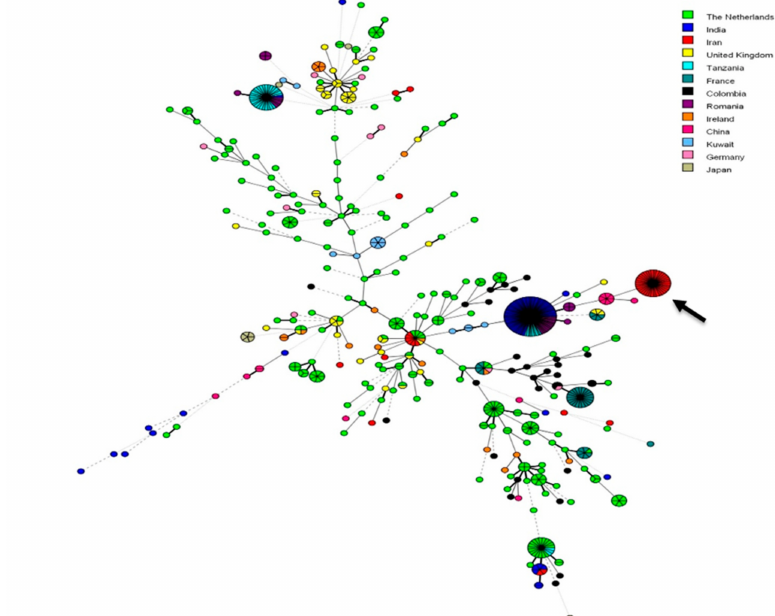
Figure 1. Minimum-spanning tree showing the genetic relationship of resistant Aspergillus fumigatus genotypes. Iranian clonal complex is illustrated by the arrow. Solid thick and thin branches demonstrate 1 or 2 microsatellite markers di ff erence, respectively; dashed branches indicate 3 microsatellite markers di ff erence between two genotypes; 4 or more microsatellite markers di ff erence between genotypes are demonstrated with dotted